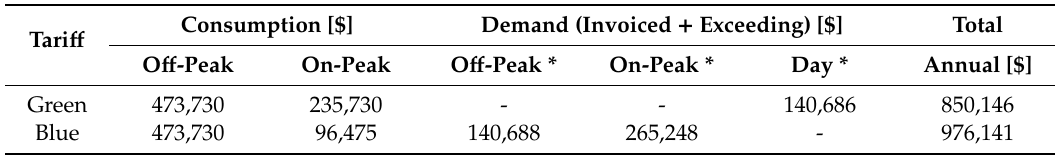
Table 4. Main results for the Reference Scenario.